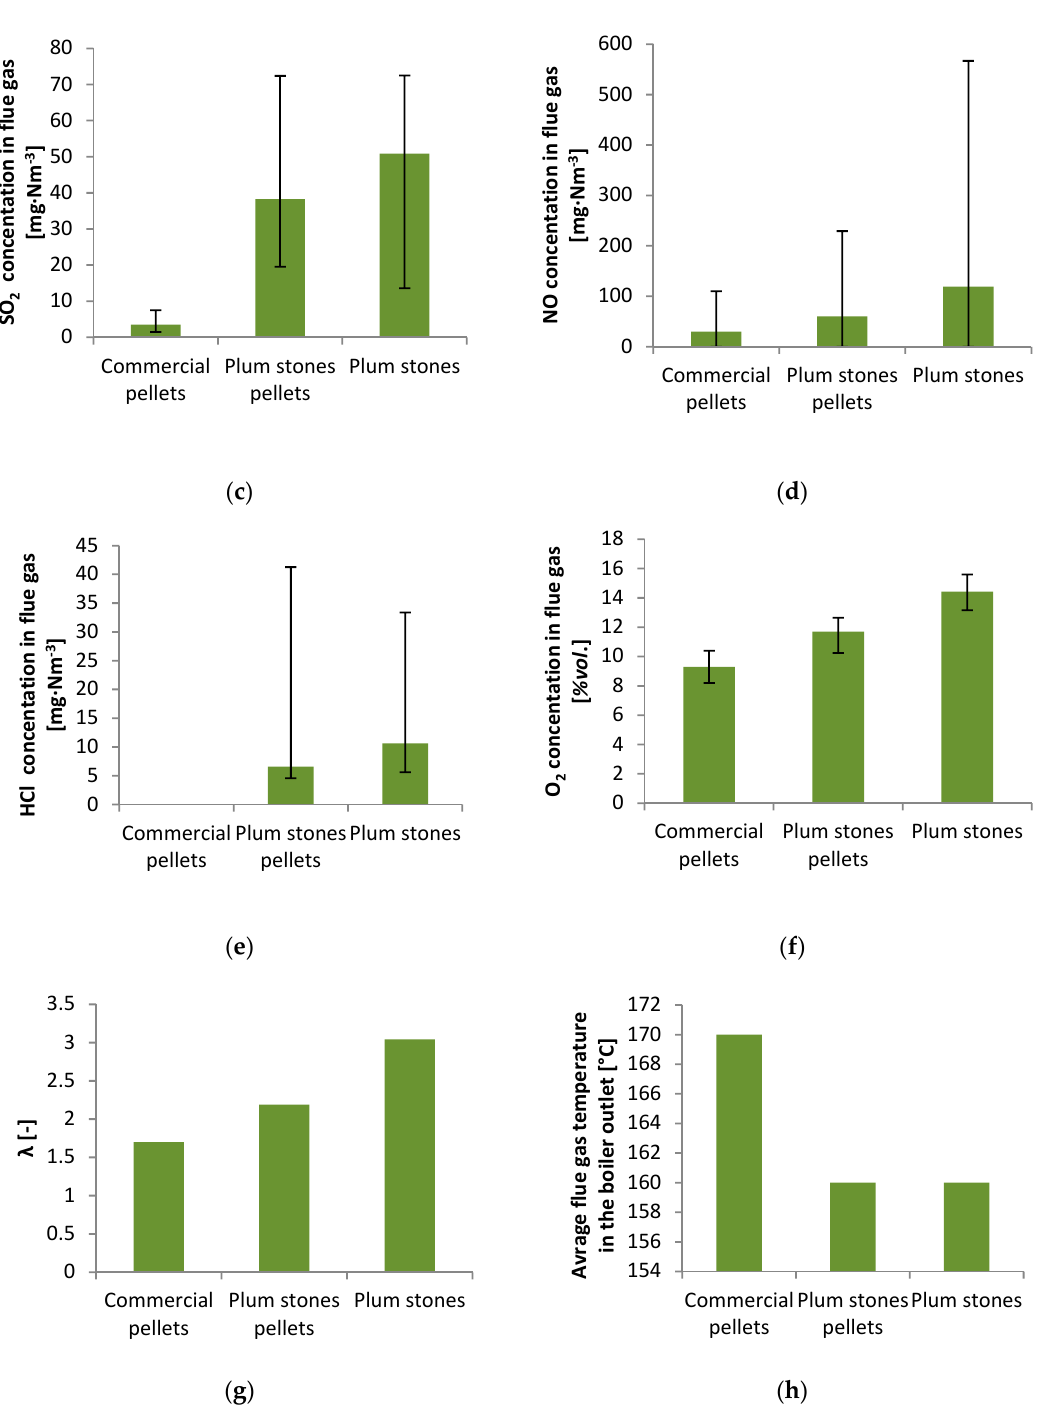
Figure 6. Conditions of combustion of commercial wood pellets, plum stone pellets containing 20 wt.% of rye bran, and plum stones without any pretreatment: ( a ) CO 2 emissions; ( b ) CO emissions; ( c ) SO 2 emissions; ( d ) NO emissions; ( e ) HCl emissions; ( f ) actual O 2 concentration in the flue gas; ( g ) excess air factor λ ; ( h ) average flue gas temperature in the boiler outlet.